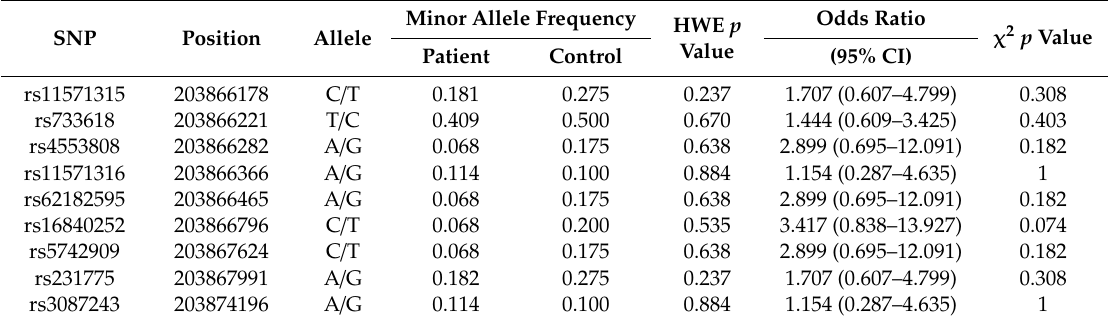
Table 3. Allele frequencies in patients and controls and odds ratio of developing Graves’ ophthalmopathy.